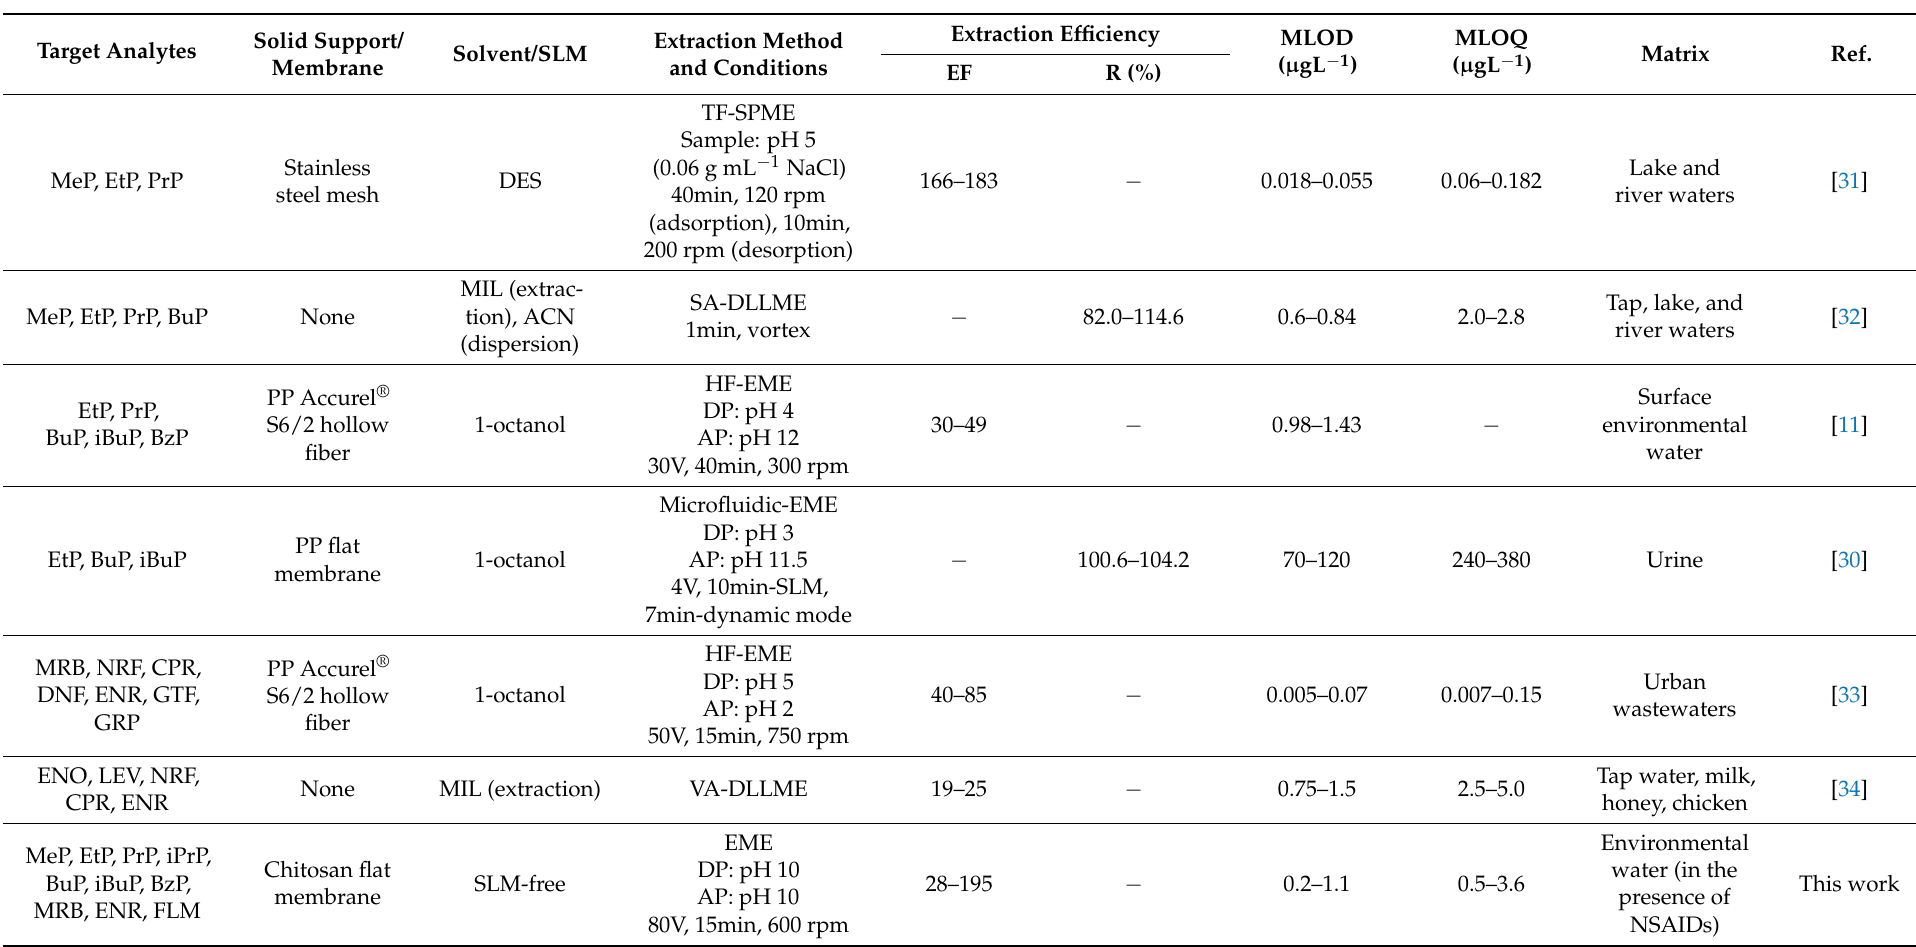
Table 3. Comparison of the proposed chitosan-based EME method with other reported microextraction procedures for the determination of parabens and FQs. HPLC-DAD determination was performed in all the compared